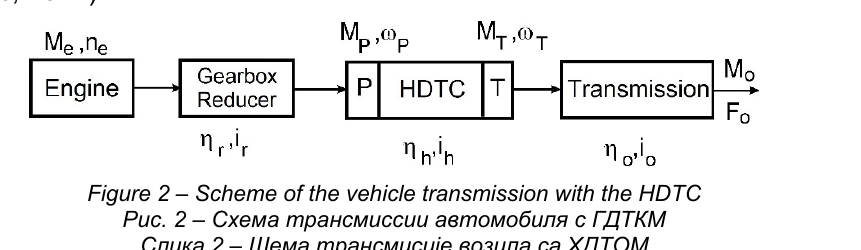
Figure 2 – Scheme of the vehicle transmission with the HDTC Рис . 2 – Схема трансмиссии автомобиля с ГДТКМ Слика 2 – Шема трансмисије возила са